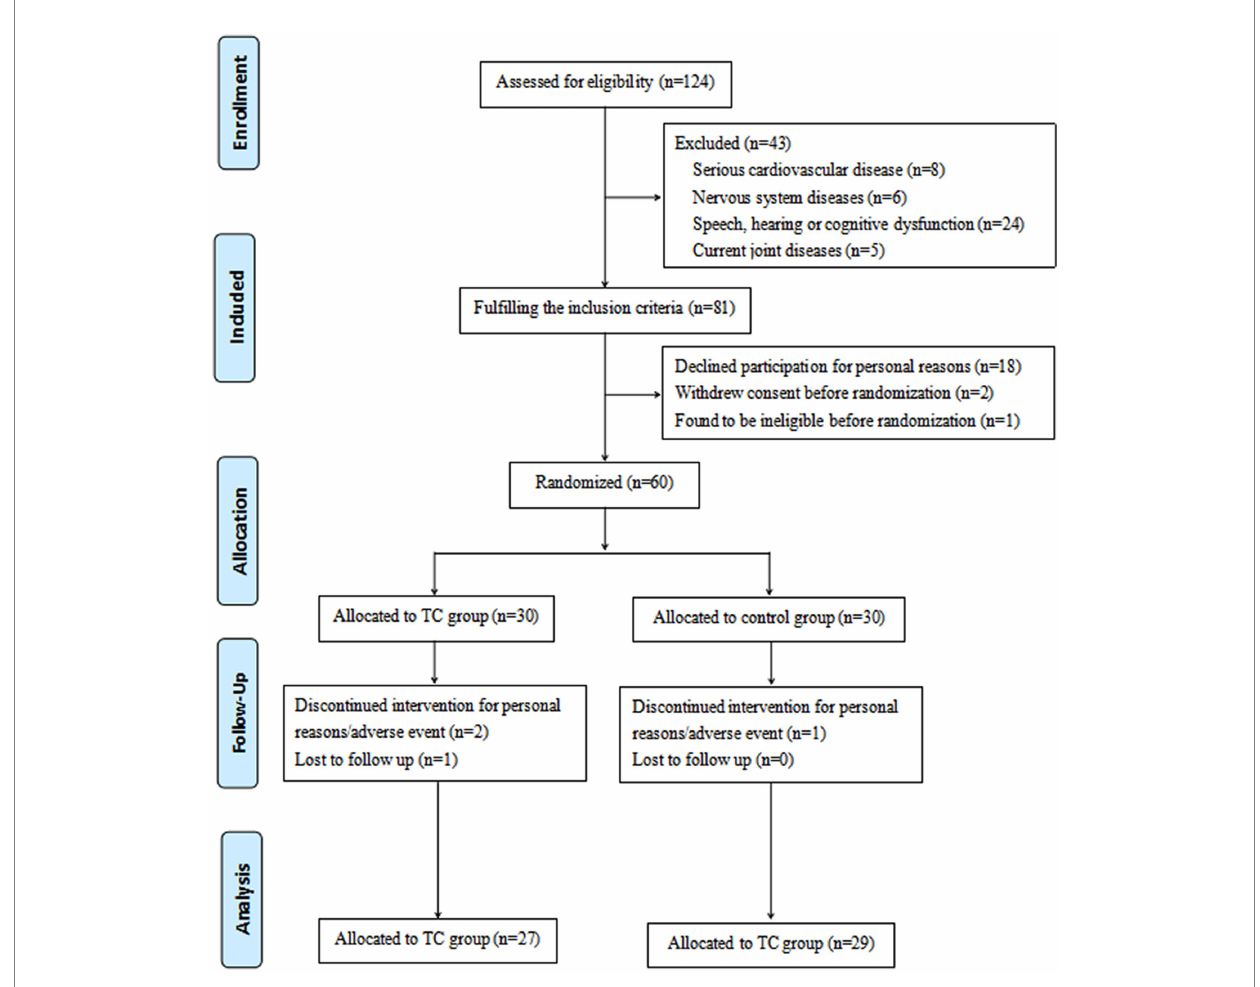
FIGURE 1 CONSORT diagram of the eligibility, exclusion and randomization